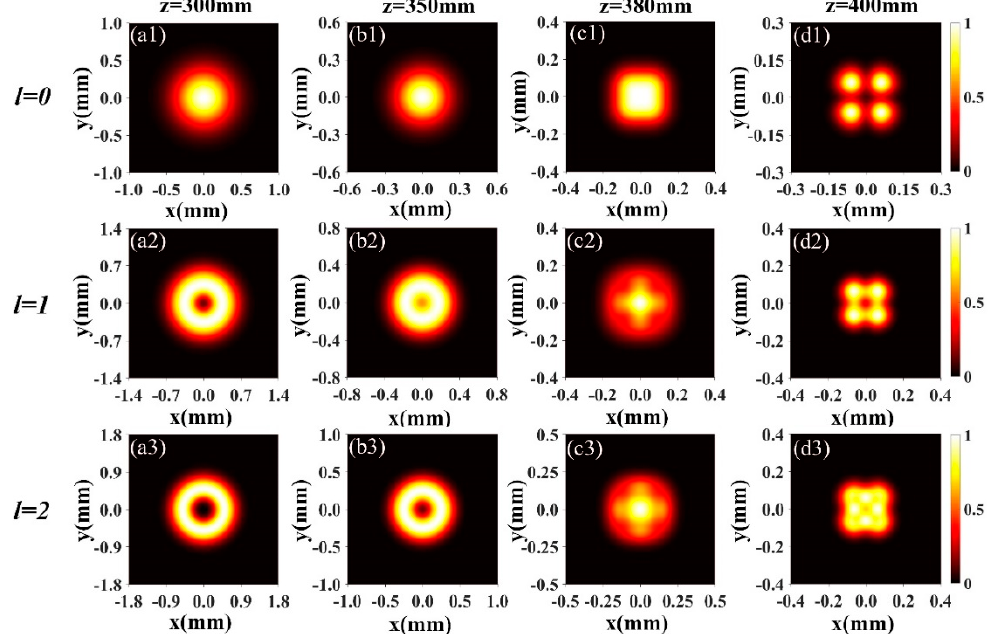
Figure 2. Normalized intensity of a focused HGCSMLG 0l beam at different distances with 0 m = , 1 n = and increasing values of the topological charge (TC).